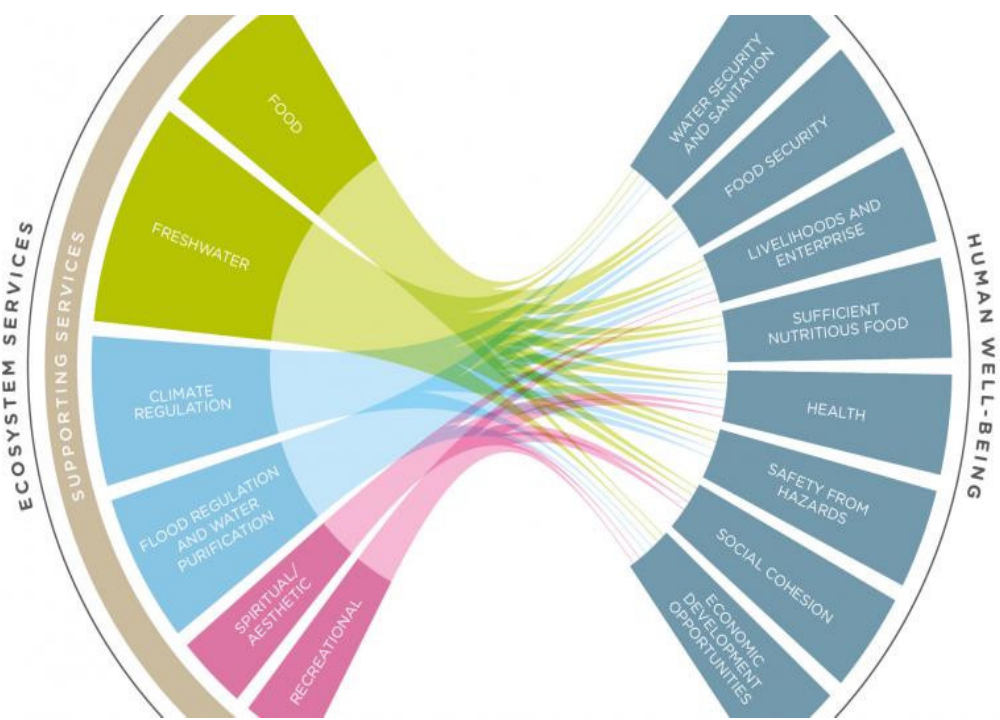
Figure 2. Linking Ecosystem Services and Human Wellbeing.